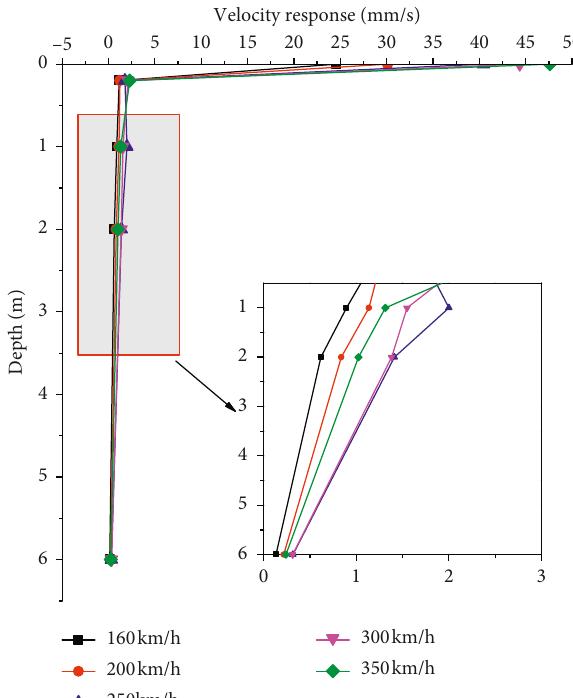
Figure 6: Vertical velocity with respect to depth.